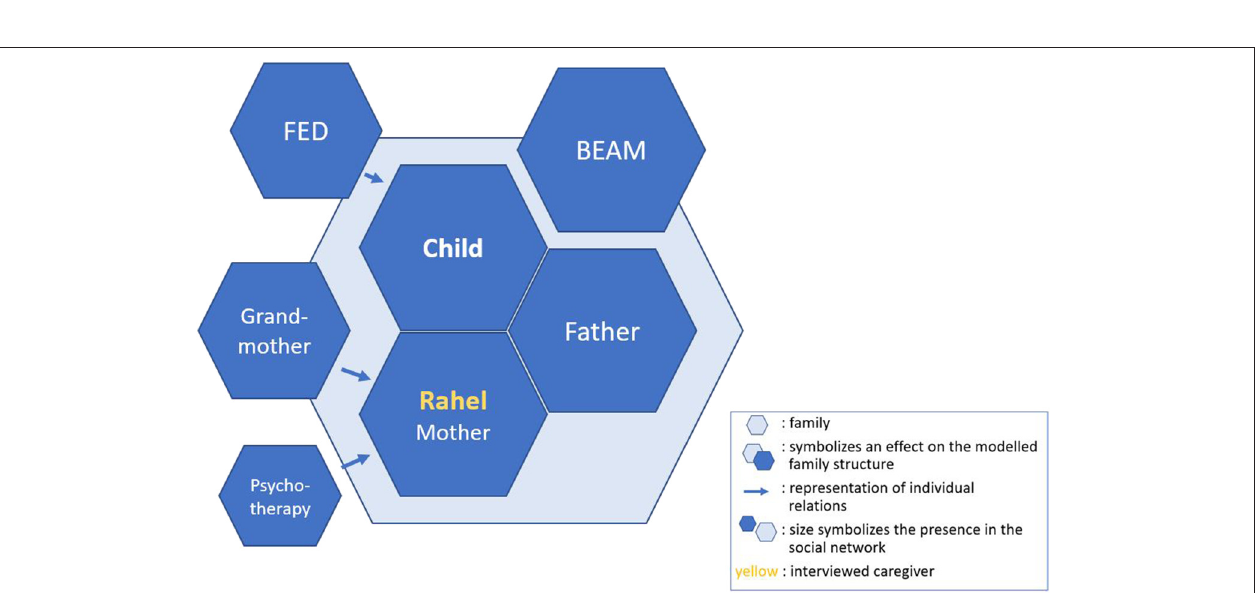
FIGURE 2 | Rahel’s social